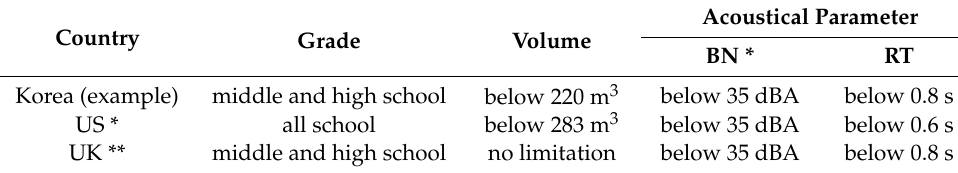
Acoustical Parameter BN * RT